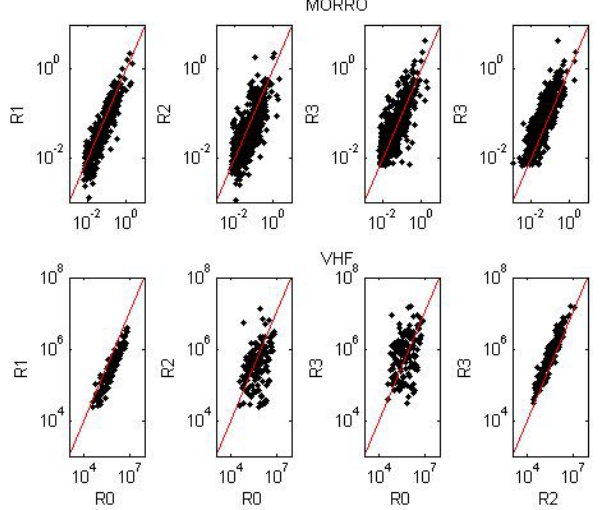
Figure 6. The relation between the strength of the different param- eters R0, R1, R2 and R3. The sample times for R0 are 9.6s for both MORRO and VHF, while the sampling times for R1, R2 and R3 are 2.4s for VHF and 2.88s for MORRO. The requirement for points to be included is that the value of R0 is twice or more than that of the background noise. The axes have arbitrary relative scales for each radar. The red lines give where the different ratios are equal to